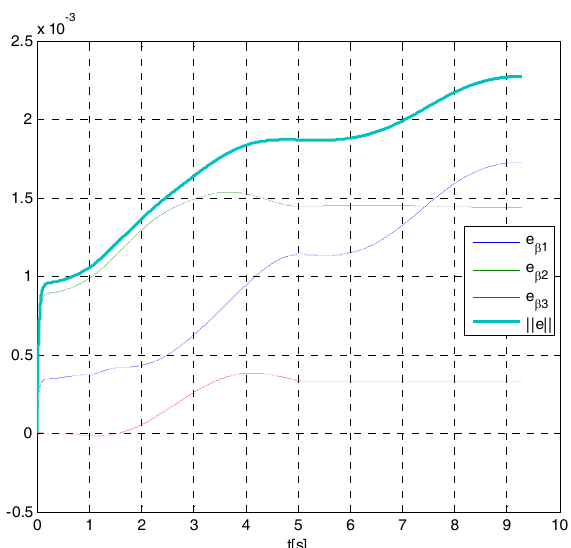
Figure 20. Time histories of the control torques with the controller (68).